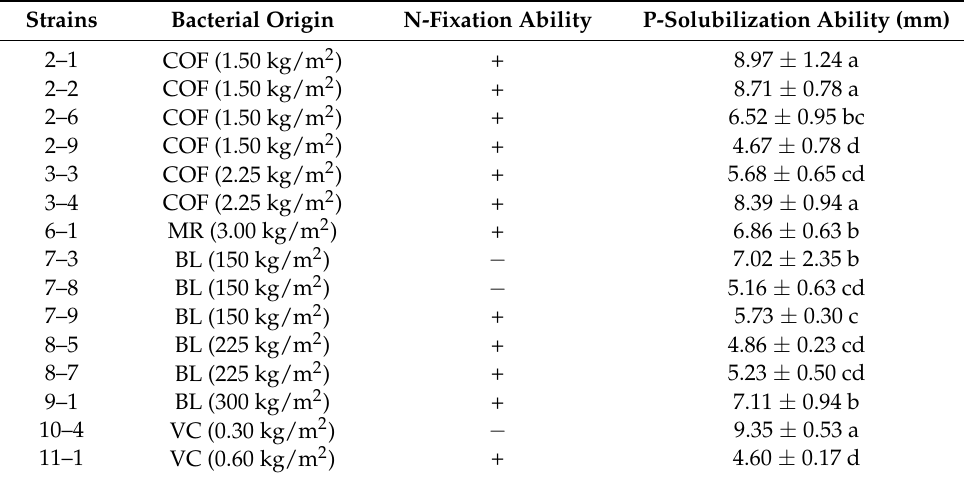
Table 7. Representative strains of P-solubilization and N-fixation bacteria originating from the newly reclaimed land amendment with different organic fertilizers.